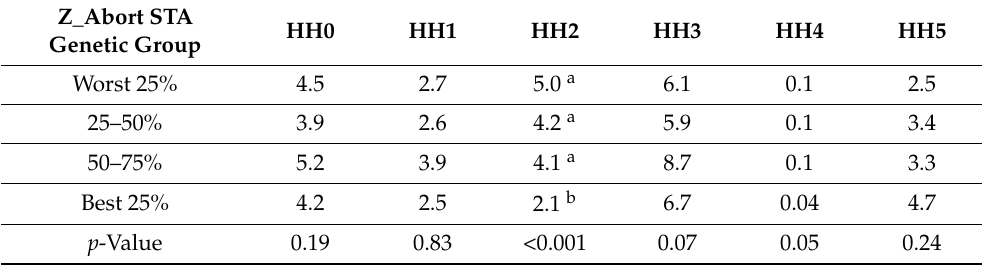
Table 9. Frequencies (%) of Holstein haplotype (HH) carriers for Z_Abort STA genetic groups. a,b Different letters within the same column represent p <